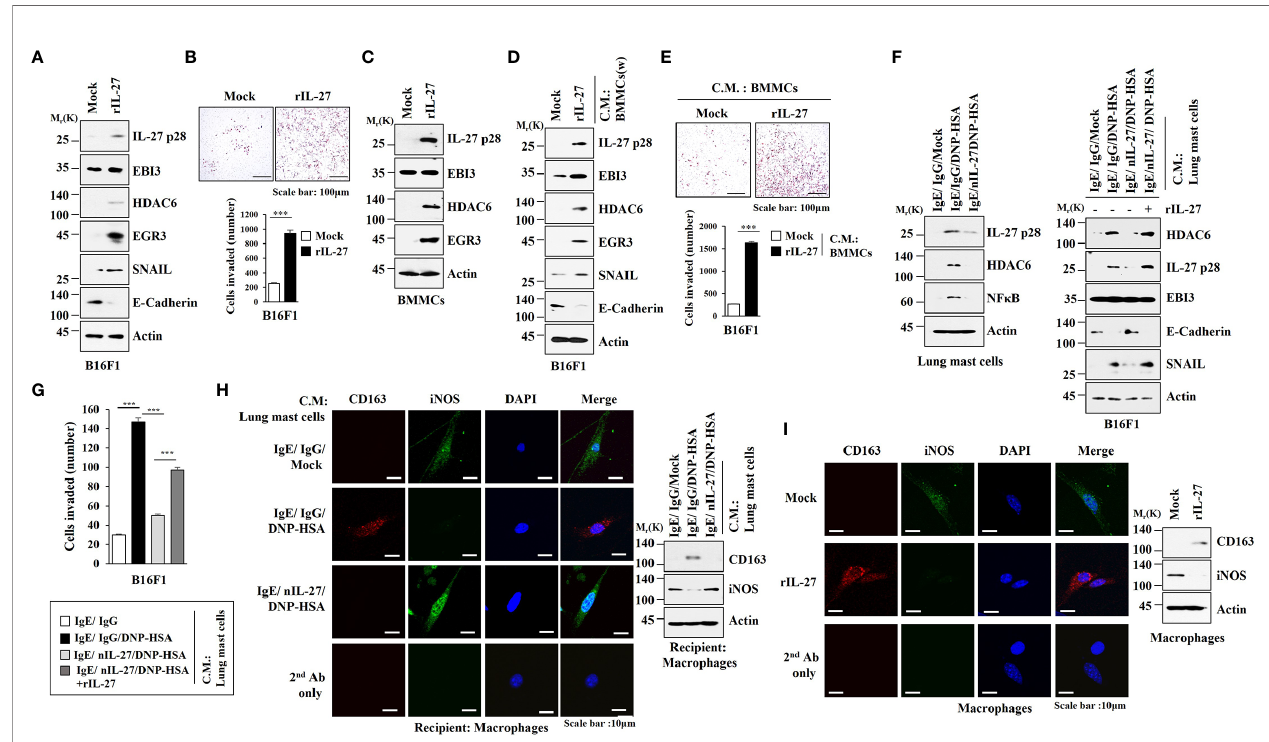
FIGURE 9 | IL-27 is necessary for enhanced invasion of B16F1 melanoma cells and lung macrophages polarization induced by mast cells. (A) B16F1 cells were treated without or with mouse recombinant IL-27 protein (20 ng) for 1 h. rIL-27 denotes mouse recombinant IL-27 protein. Representative blots of three independent experiments are shown. (B) Invasion of B16F1 cells was determined. *** p <0.001. Average values of three independent experiments are shown. (C) BMMCs were treated without or with IL-27 protein (20 ng/ml) for 1 h. Representative blots of three independent experiments are shown. (D) Culture medium of BMMCs treated with mouse recombinant IL-27 protein (20 ng/ml) for 2 h was removed and replaced with serum-free DMEM. At 12 h after, culture medium was added to B16F1 cells for 16 h. W denotes removal of culture medium of the cells treated with mouse recombinant IL-27 protein. Representative blots of three independent experiments are shown. (E) Invasion of B16F1 cells was determined. *** p <0.001. Average values of three independent experiments are shown. (F) Lung mast cells were treated with DNP-speci fi c IgE along with the indicated antibody (each at 10 m g/ml) for 24 h, and stimulated by DNP-HSA along without or with rIL-27 (20 ng/ml) for 1 h (left). The culture medium was then added to B16F1cells for 16 h (right). (G) Same as (F) except that invasion of B16F1 cells was determined. *** p <0.001. Average values of three independent experiments are shown. (H) Lung mast cells were treated with DNP-speci fi c IgE along with the indicated antibody (each at 10